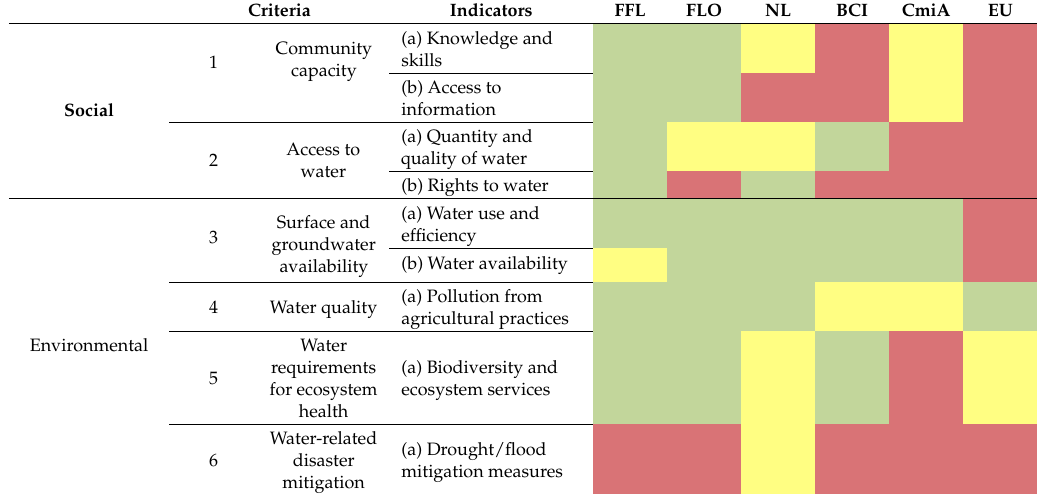
Table 2. Water sustainability in six cotton certification schemes. NL: Naturland.